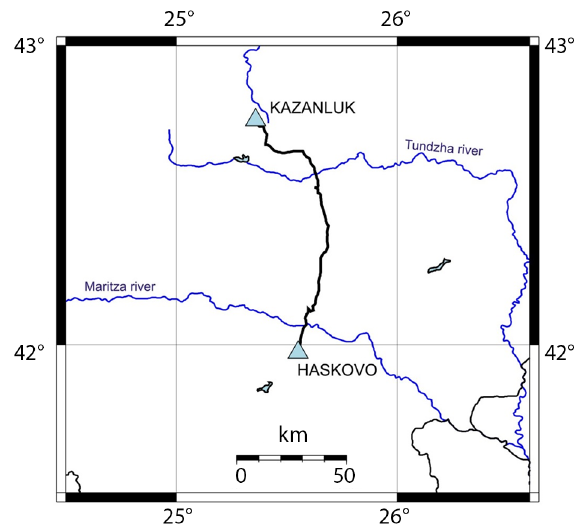
Figure 1. First order leveling line Kazanluk – Haskovo The leveling line consists of 89 leveling distances, mea- sured two times, fore and back with 2267 and 2243 set-ups respectively. The measurements were made with a precise digital level Sokkia SDL 1X with couple invar rods. For every leveling distance difference in elevation d , between fore and back leveling, is calculated. The accepted limit is: ≤ ± 1.5 where: S is the length of leveling distance in km; d is ob- tained in